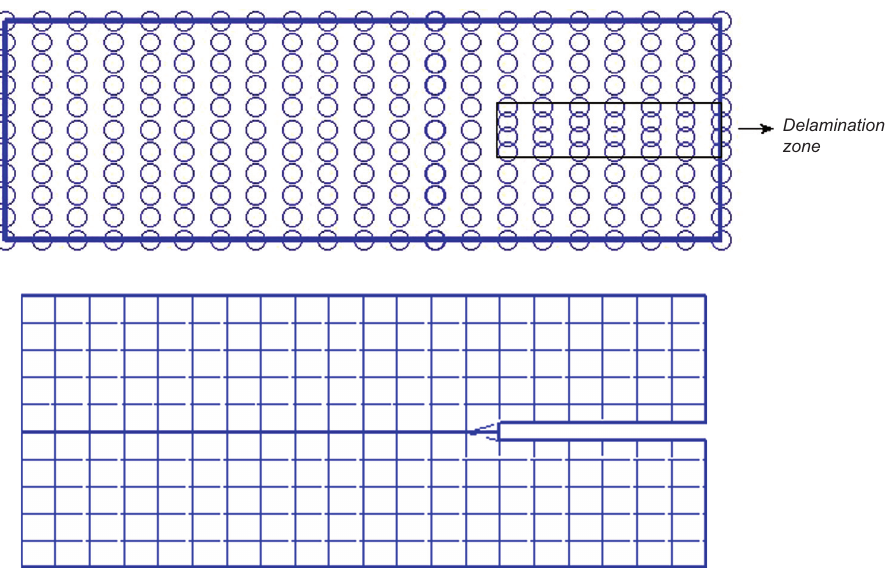
Figure 4 Background meshes of integration cells for the EFGM.